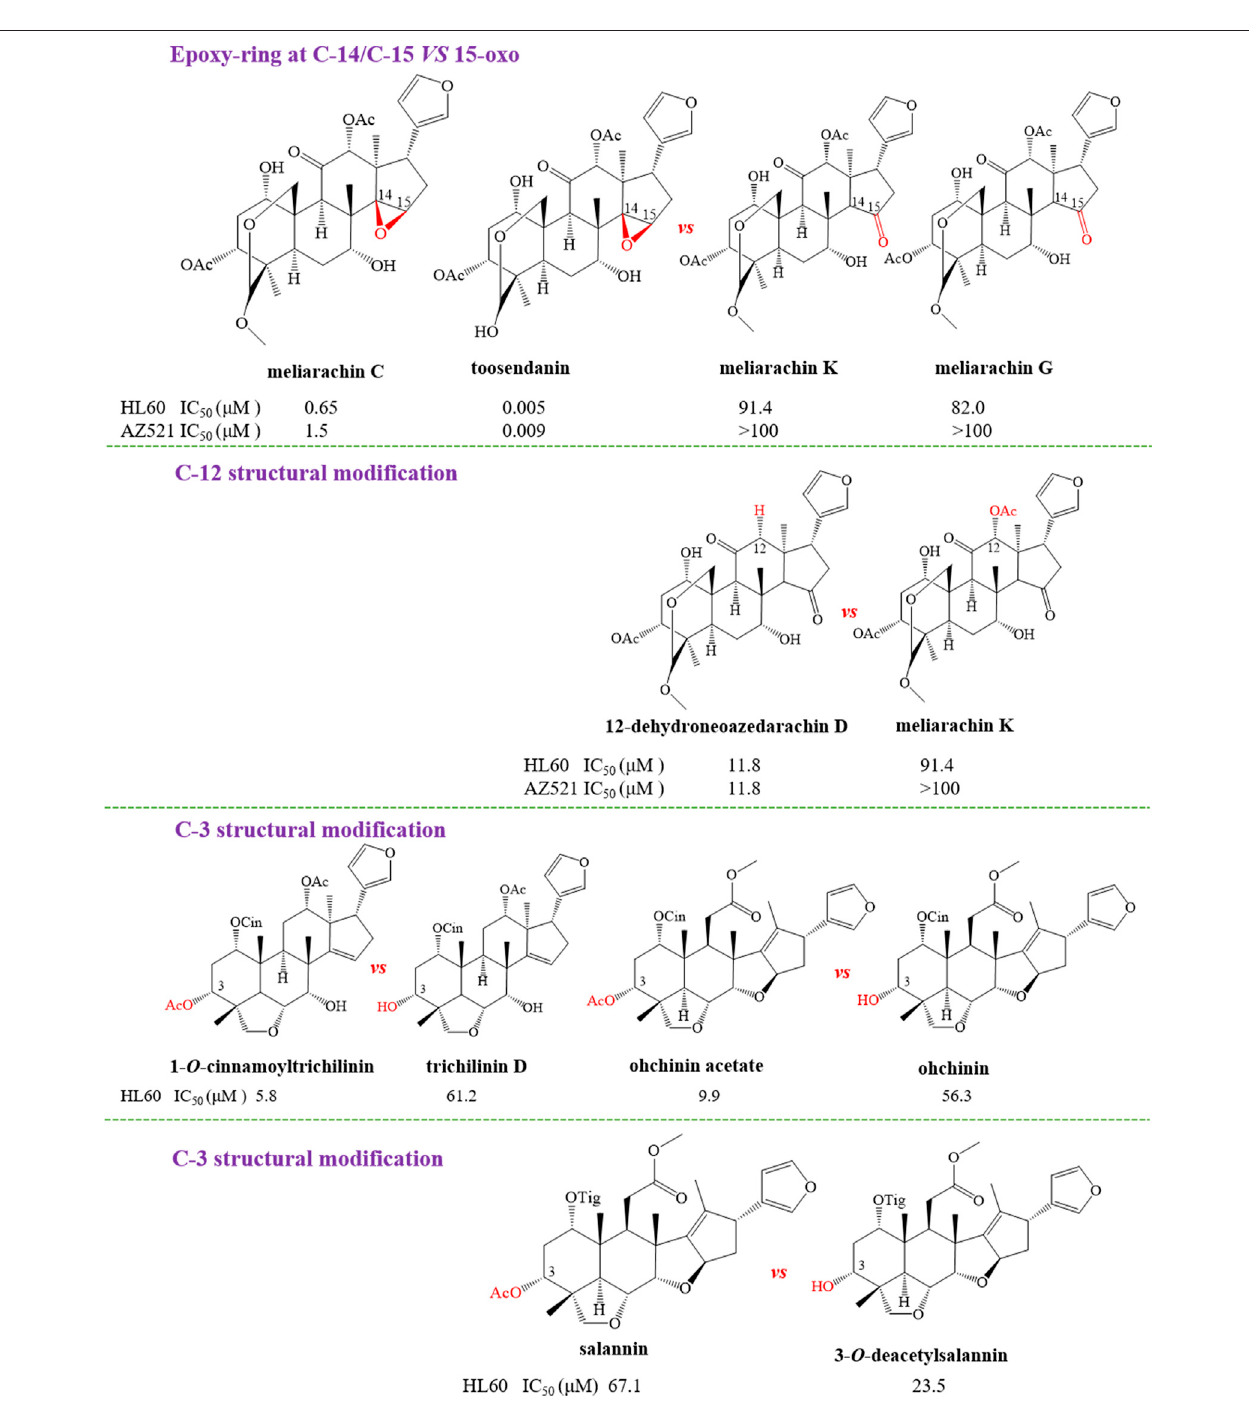
FIGURE 10 | The anti-tumor structure – activity relationship of